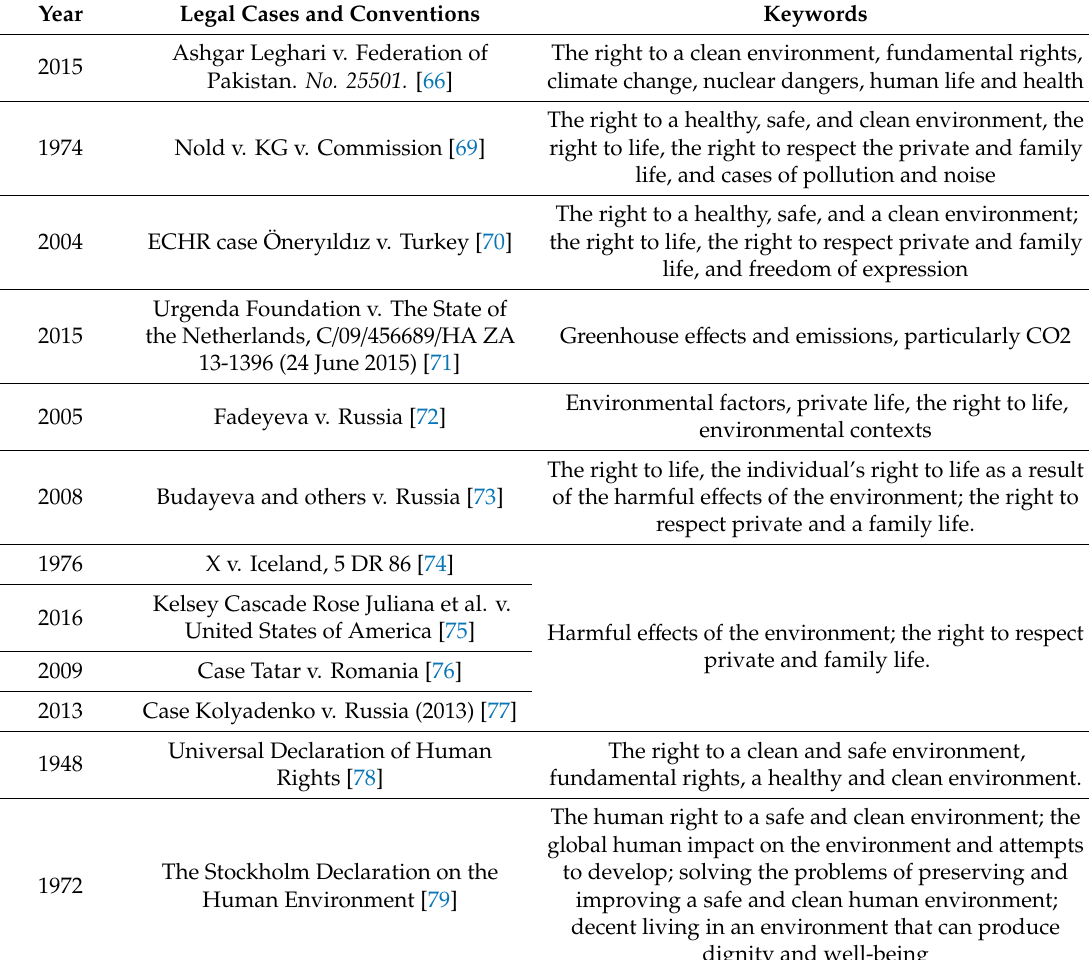
Table 2. Legal documents related to a clean